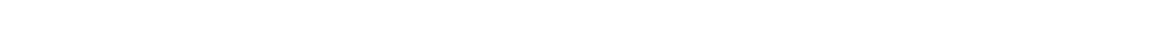
Frontiers in Nutrition | Neuroenergetics, Nutrition and Brain